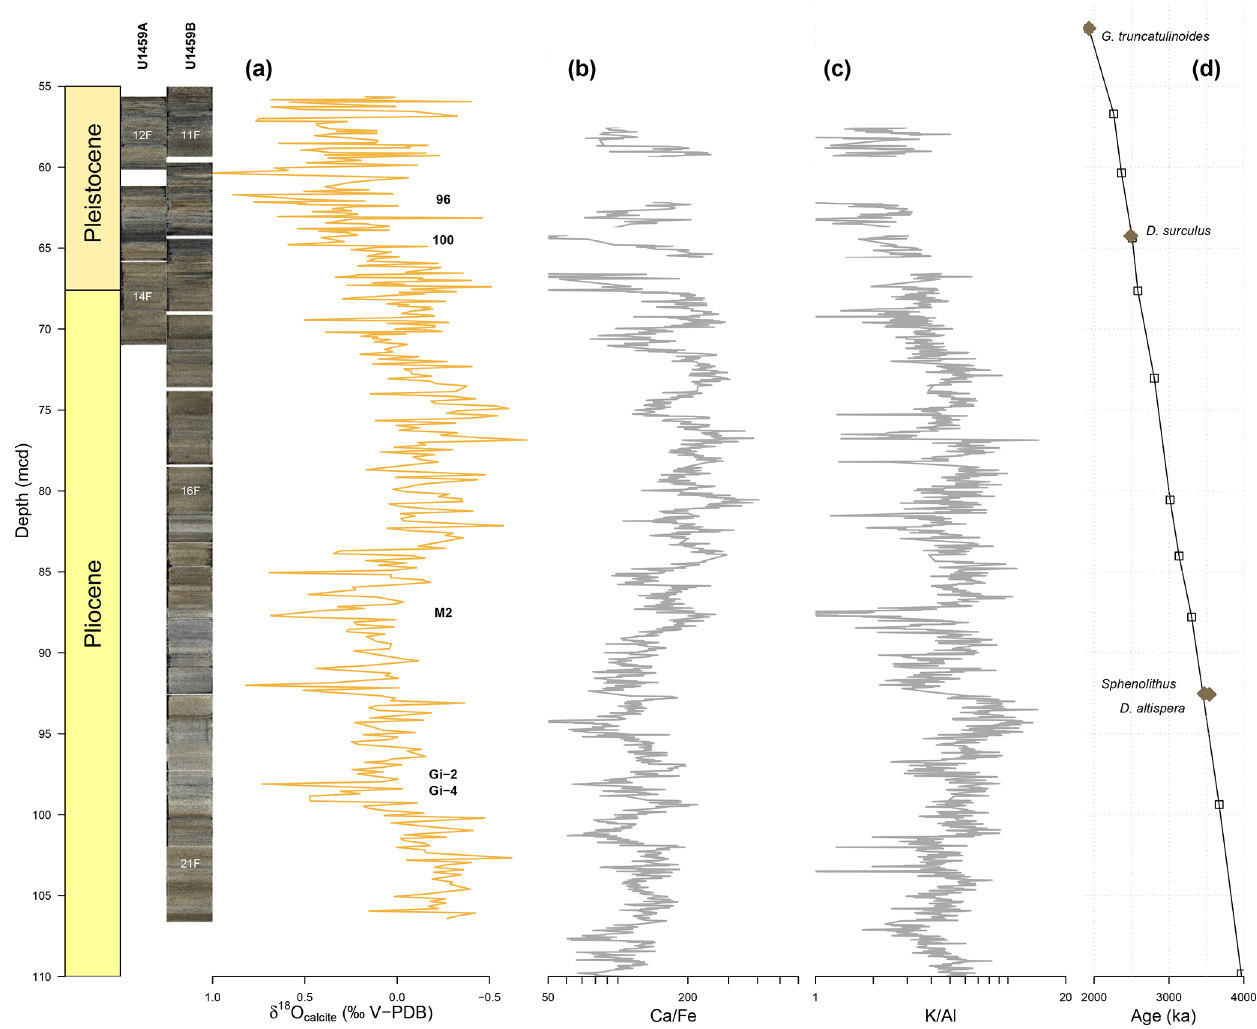
Figure 3. IODP Site U1459 depth series and age–depth model. (a) Planktonic δ 18 O calcite depth series, produced by merging the measurement series in De Vleeschouwer et al. (2019b, N = 143) with the new data presented here ( N = 238). The stratigraphic positions of marked glacial intervals (MIS 96, 100, M2, Gi-2, and Gi-4) are indicated. (b, c) XRF-derived Ca / Fe and K / Al depth series, interpreted in De Vleeschouwer et al. (2019b) as proxies for detrital input and aeolian kaolinite flux, respectively. Both element ratios are plotted on a logarithmic scale. (d) The age–depth model by De Vleeschouwer et al. (2019b) is extended into the early Pleistocene by three additional age–depth tie points. Biostratigraphic markers are indicated by brown diamonds. Age–depth model tie points are indicated by open